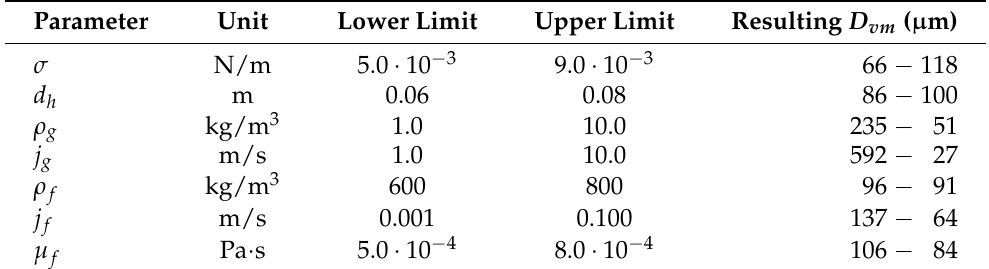
Table 4. Ranges for D vm for varying values of the parameters in Equation (17). At each line, the other parameters are kept at their baseline value.